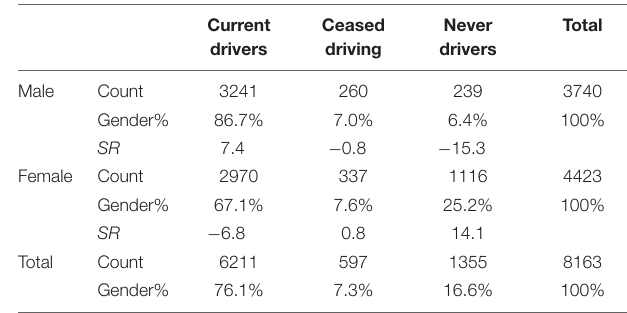
2 For ease of interpretation the number of Age categories was reduced to three with the first two spanning 15 years.